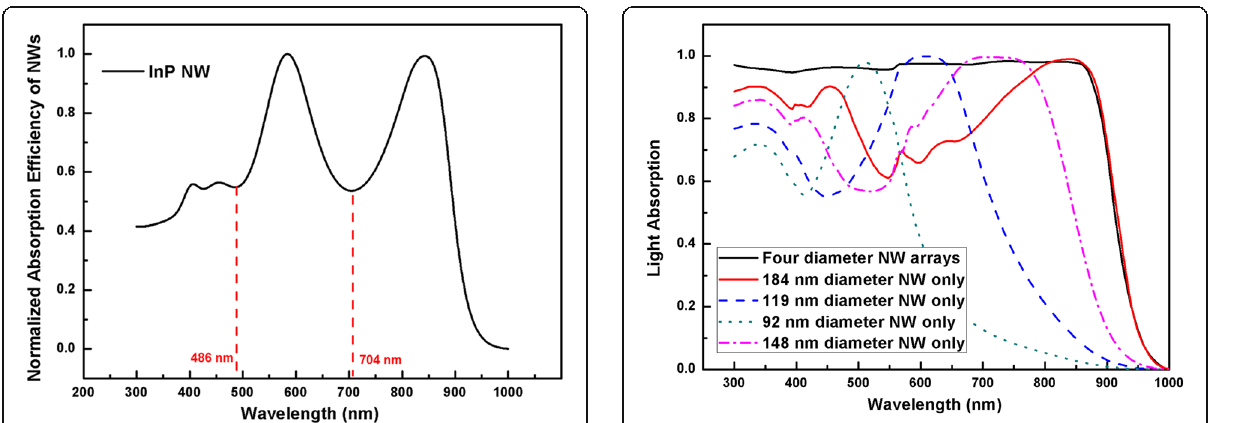
Fig. 8 Light absorption of four diameter InP NW arrays